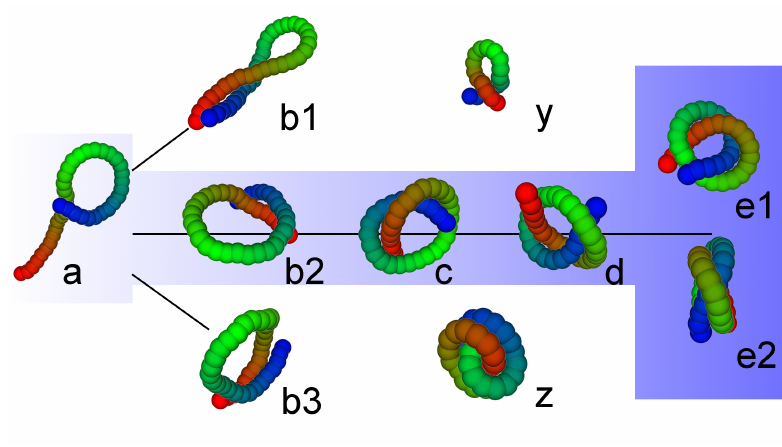
Figure 8. Path to the trefoil knot for N = 40 and L = 0.51 ( e1 and e2 show two different views) starting from a tennis racket like configuration ( a ) when one reduces temperature (or energy) going from left to right through b2 , c and d . Configurations b1 and b3 coexist with b2 , configuration y is the ground state for N = 20 and L = 0.52, while z is the ground state for N = 40 and L = 0.52.